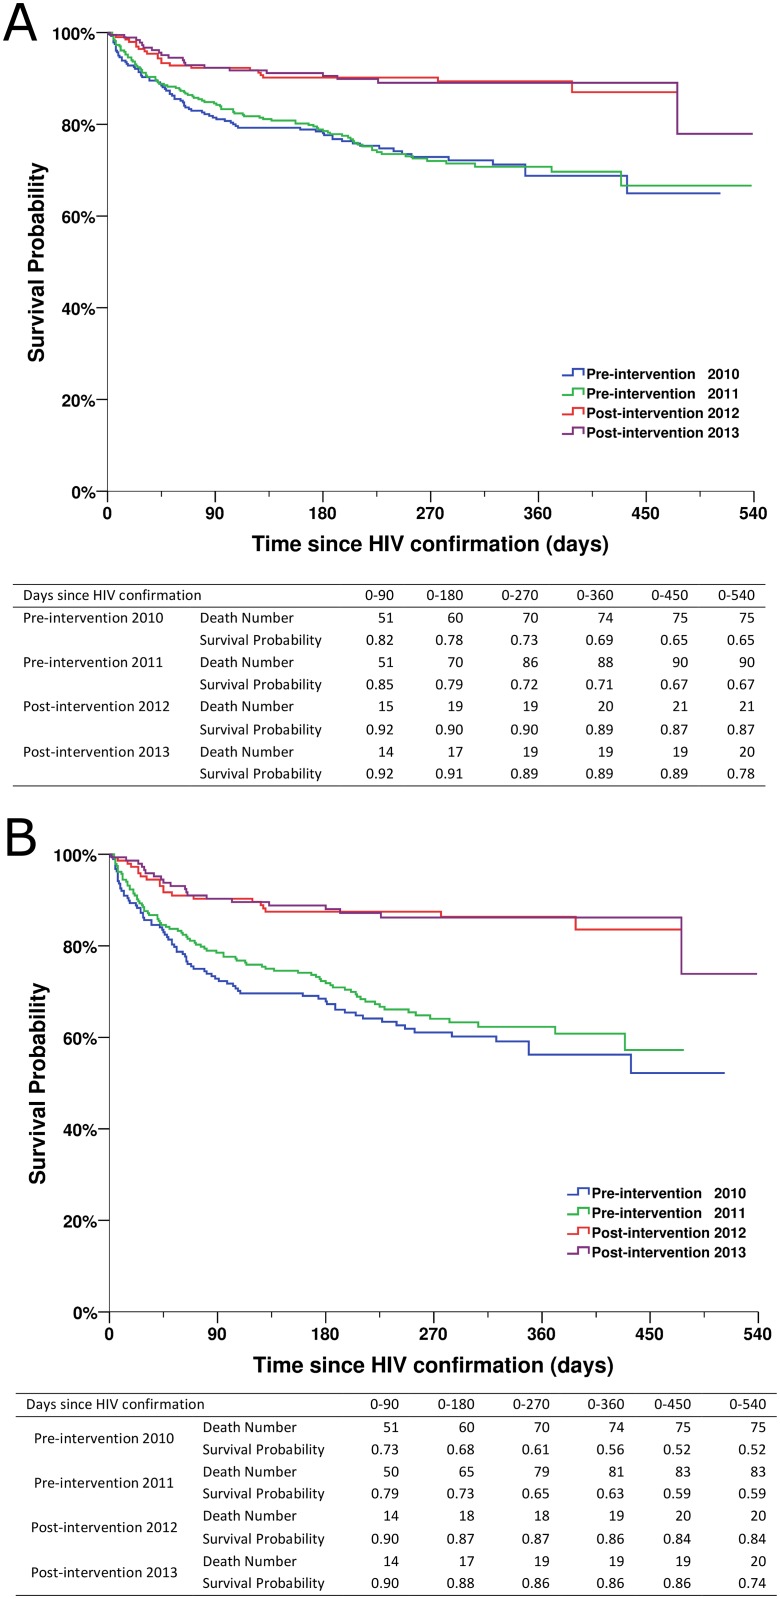
Kaplan-Meier survival curves for newly diagnosed HIV cases in the pre-intervention 2010, pre-intervention 2011, post-intervention 2012, and post-intervention 2013 phases in Guangxi, China.(A) For all HIV cases. (B) For individuals with CD4 count ≤ 350 cells/mm3 or missing CD4 but reported as AIDS cases.